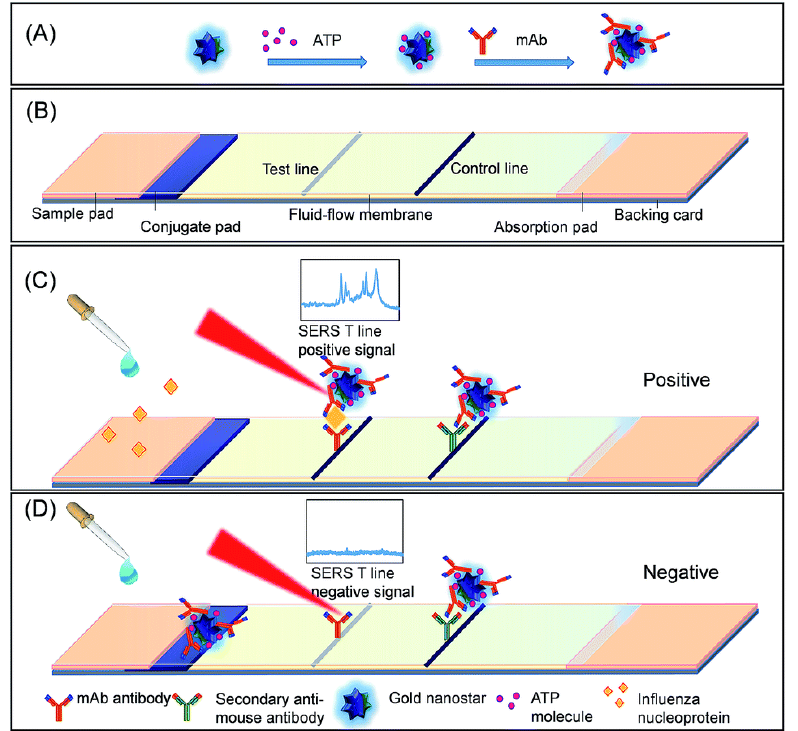
Figure 8. SERS-LFIA test system: ( A ) AuNS is functionalized with 4-ATP and conjugated to monoclonal antibodies to form the SERS tags; ( B ) LIFA test strip, and the response of the SERS-LFIA system to ( C ) influenza A nucleoprotein and ( D ) a negative control. Reproduced from Ref. [119] with permission of The Royal Society of Chemistry.